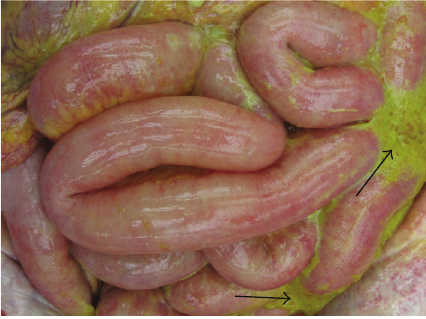
Figure 3: Pus in the colon.